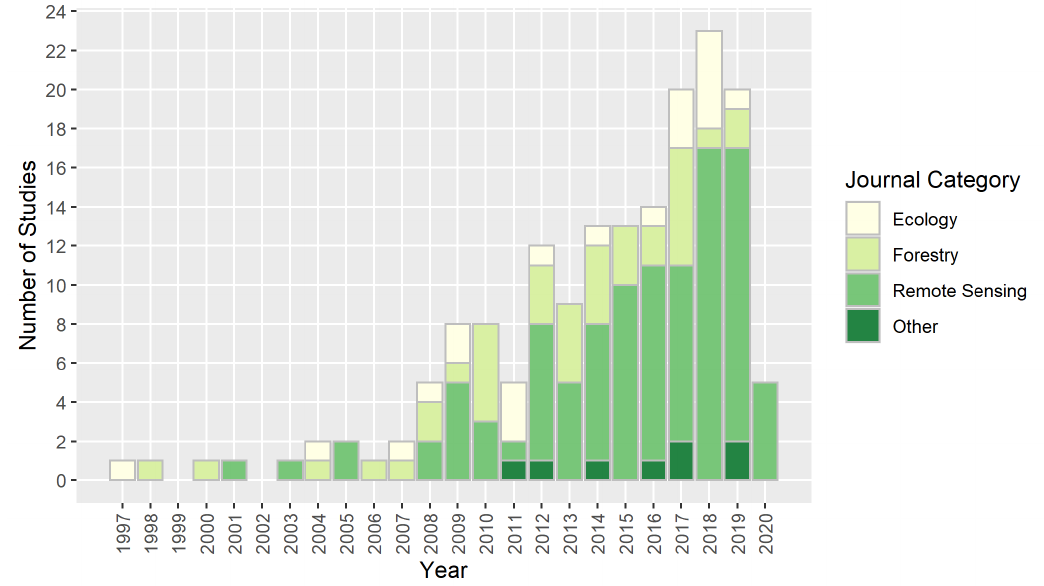
Figure 7. Studies ordered by year of publication.